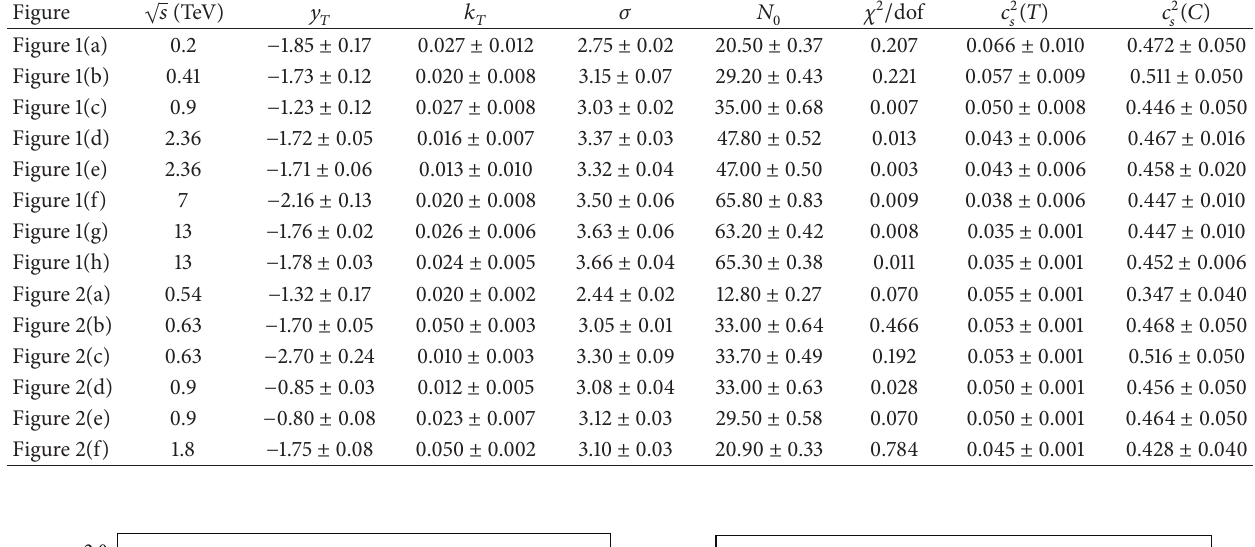
Table 1: Fitted values of 𝑦 𝑇 , 𝑘 𝑇 , 𝜎 , 𝑁 0 , and 𝜒 2 / dof corresponding to the curves in Figures 1 and 2 which show the pseudorapidity distributions in 𝑝 - 𝑝 and 𝑝 - 𝑝 collisions at different energies. The last two columns show 𝑐 2 𝑠 (𝑇) and 𝑐 2 𝑠 (𝐶) .